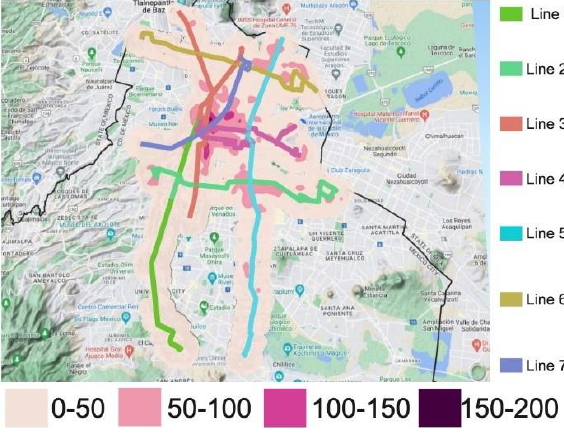
Figure 10. Heatmap of gender-based crimes on subway bus lines in CDMX.